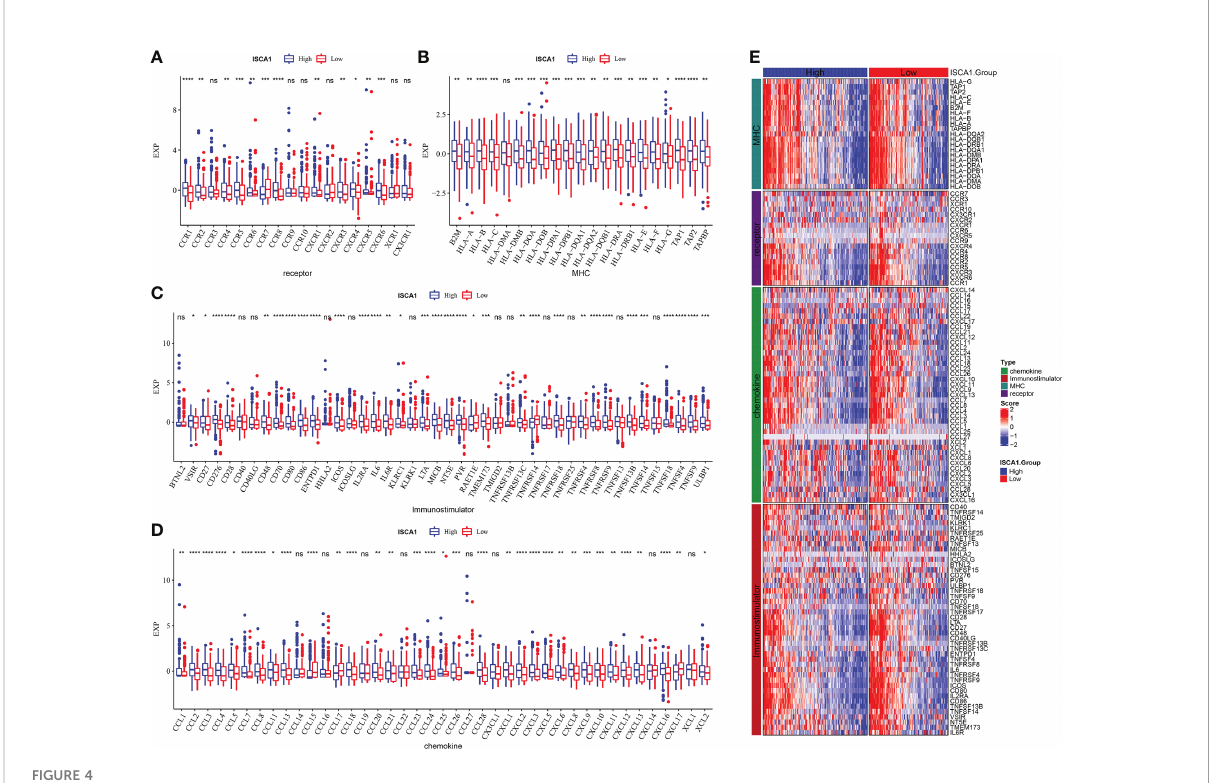
FIGURE 4 Comparative analysis of the immune status of ISCA1 group in BLCA. (A – D) : The expression differences of different types of genes (chemokines, receptors, MHC, and immunostimulants) grouped by ISCA1 in BLCA; (E) Heatmap of differences in the expression of different types of genes (chemokines, receptors, MHC, and immunostimulants) grouped by ISCA1 in BLCA (* represents p < 0.05, ** represents p < 0.01, *** represents p < 0.001, **** represents p < 0.0001, ns represents p >